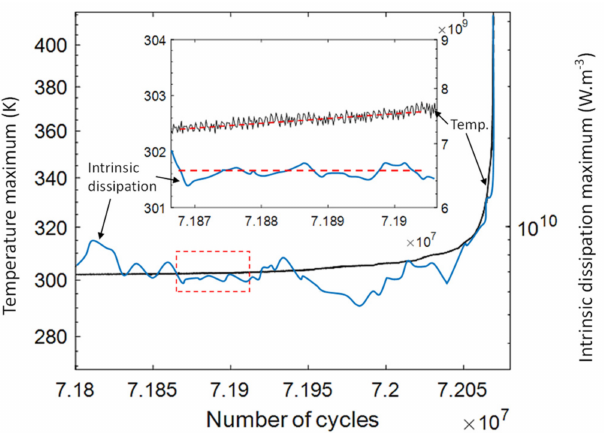
Figure 6. Evolution of the maximum temperature and the maximum intrinsic dissipation per image in terms of the number of